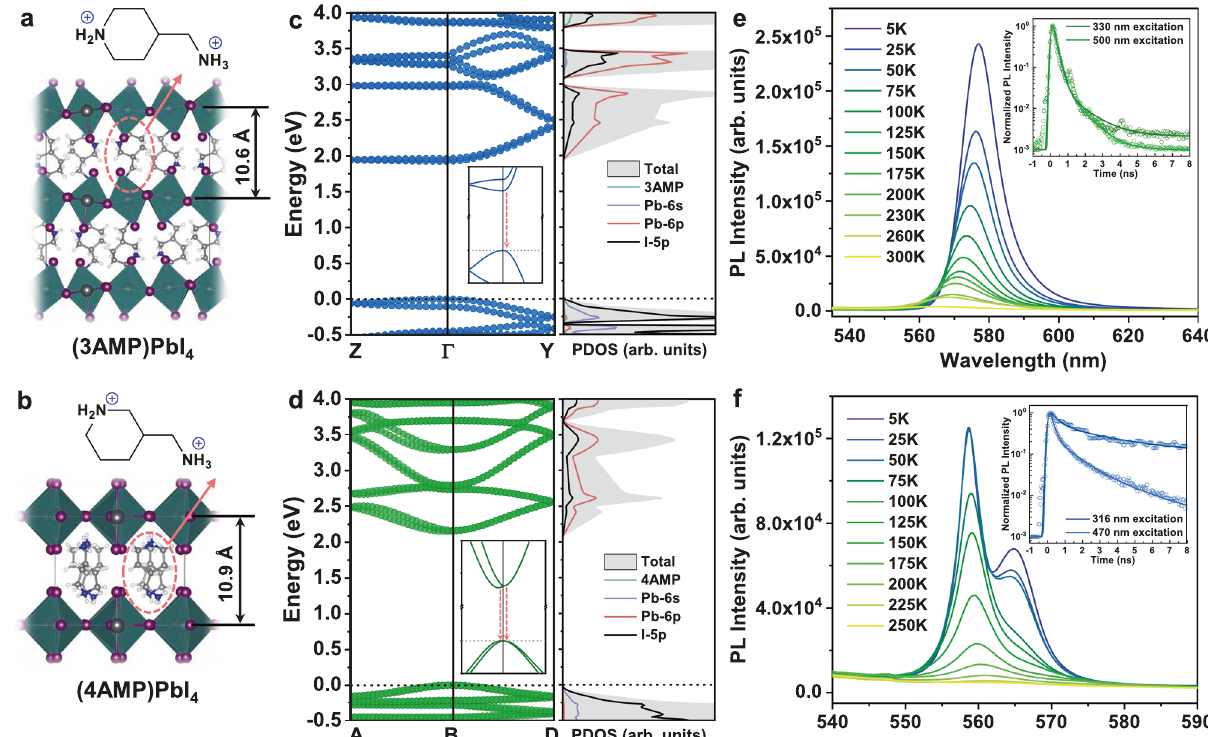
Fig. 1 Crystal structure, electronic bands, and PL spectra of 2D Dion – Jacobson perovskites. a , b Crystal structures of 2D Dion – Jacobson perovskites, (3AMP)PbI 4 and (4AMP)PbI 4 , together with the chemical structures of the organic cations. c , d Electronic bands and total and projected density of states (PDOS) of (3AMP)PbI 4 and (4AMP)PbI 4 calculated at the DFT HSE06 level with spin-orbit coupling (SOC). Enlarged electronic bands near the valence band maximum and conduction band minimum are shown in the insets. e , f Temperature-dependent PL spectra of the (3AMP)PbI 4 and (4AMP)PbI 4 fi lms, together with the time-resolved PL decays for the emission from the (3AMP)PbI 4 fi lm at 565 nm and the emission from the (4AMP)PbI 4 fi lm measured at 560 nm and room temperature. The solid lines represent fi ts to a biexponential decay function. Note that the observed spikes in ( e ) could be due to the presence of fi lm irregularities that lead to small re fl ections inside the fi